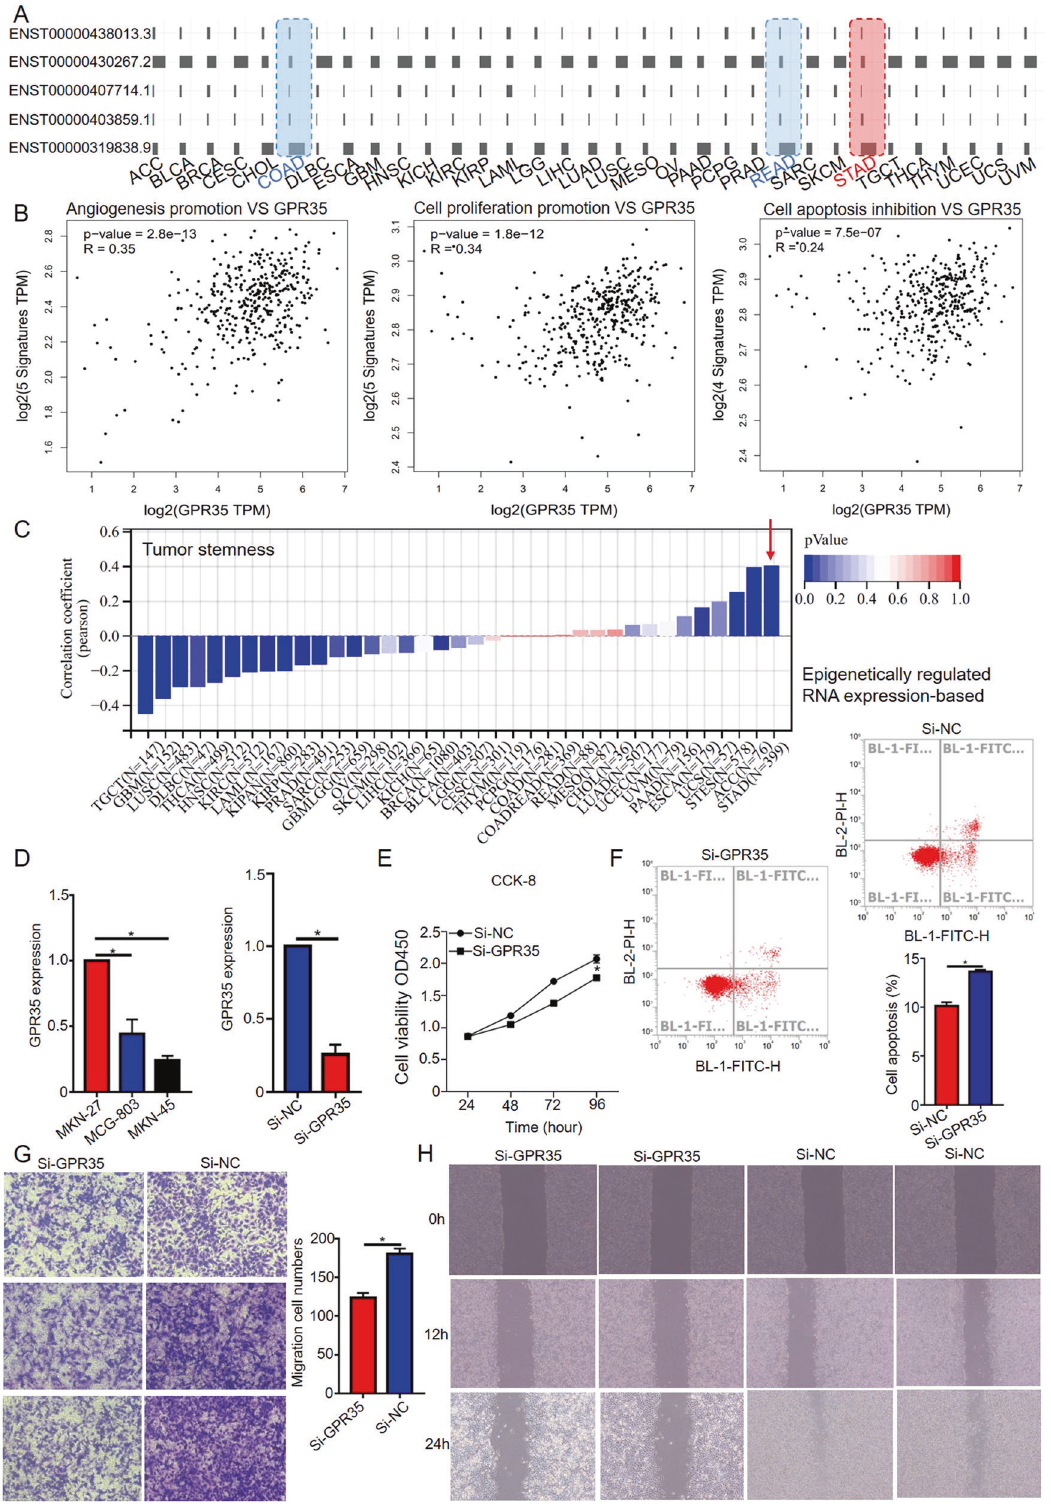
Fig. 5 GPR35 promotes cell proliferation and migration for GC. A Landscape for transcript expression of GPR35 in pan-cancer. B The correlation between signature gene expression (angiogenesis, cell proliferation, and apoptosis) and GPR35 expression in GC. C Correlation coef fi cient between tumor stemness and GPR35 for different cancers. D GPR35 expression level in different GC cells. E Cell proliferation ability decreased after infected si-GPR35 (24 h). F si-GPR35 promotes cell apoptosis for MKN-27. The representative images and quantitative data of Transwell assays ( G ) and wound healing assays ( H ) of MKN-27 cells after different treatments, respectively.